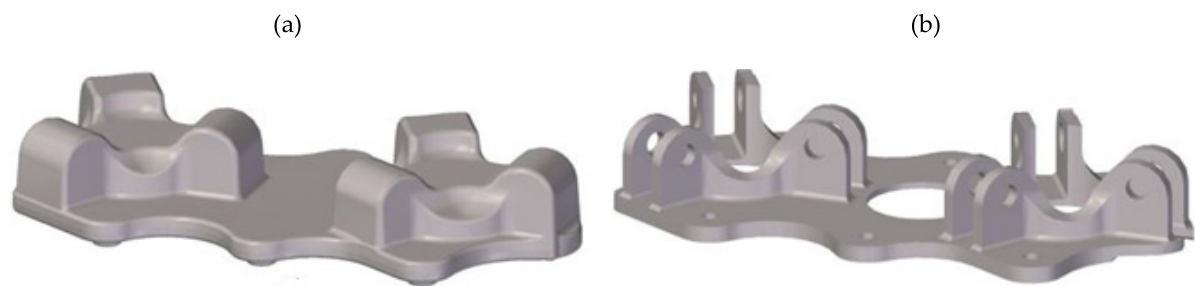
Figure 1. 3D models of the forging of aircraft mount from AZ61 alloy ( a ) and of the finished aircraft mount ( b ).